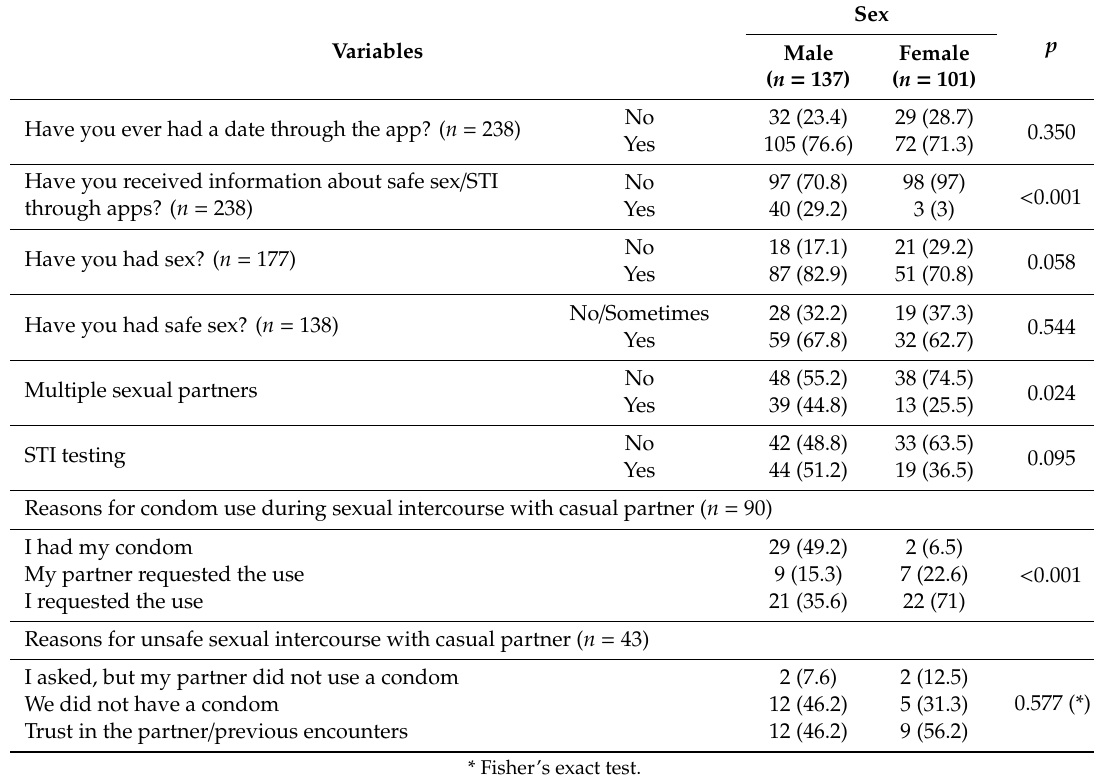
Table 2. Factors associated with casual partner encounters and sexual behaviors by sex, n (%).